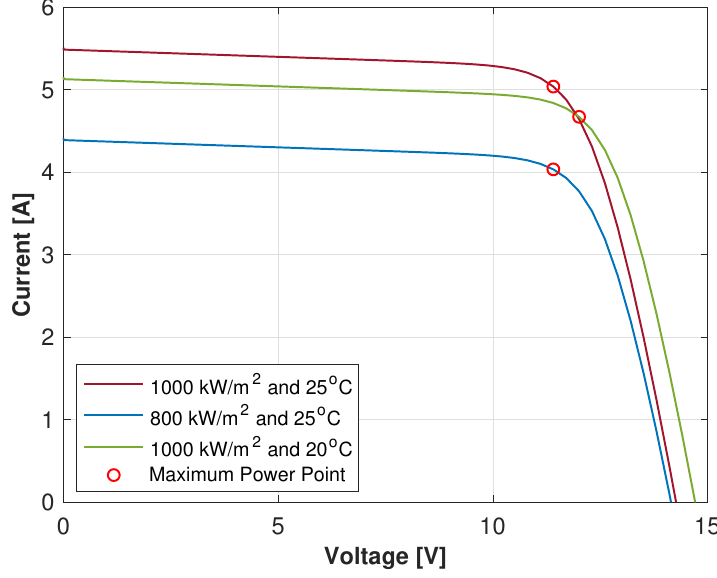
Figure 2. Current against Voltage profiles, for different Irradiances and Temperatures input